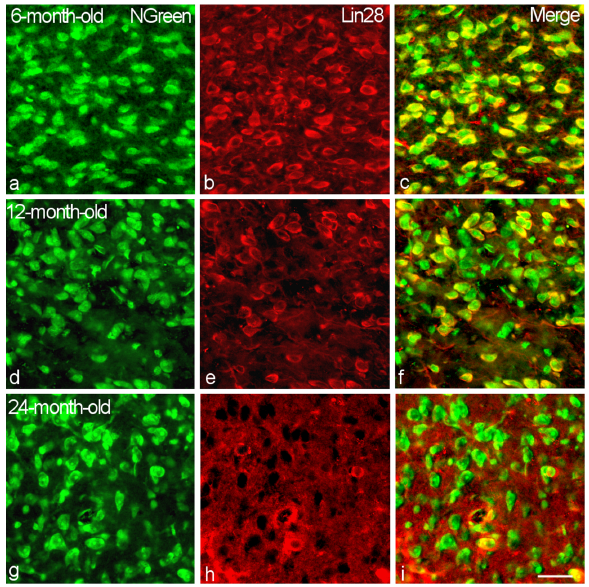
Figure 1. Immunostaining of Lin28-IR neurons in the VMH of 6-month-old ( a – c ), 12-month-old ( d – f ) and 24-month-old ( g – i ) male rats. Double labeling of neuronal marker NGreen ( a , d , g , green, left panel), Lin28 ( b , e , h , red, middle) and composite image ( c , f , i , right). Bar, 25 µm.